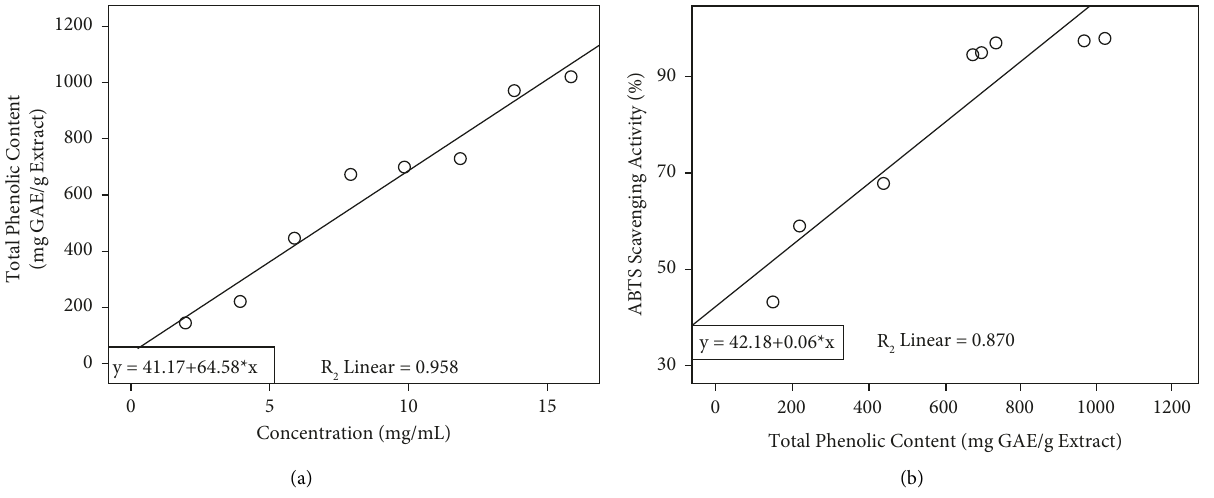
Figure 1: (a) Total phenolic content of Moringa Peregrina extract at experimented concentrations, (b) Correlation between total phenolic content and antioxidant activity of Moringa peregrina extract.